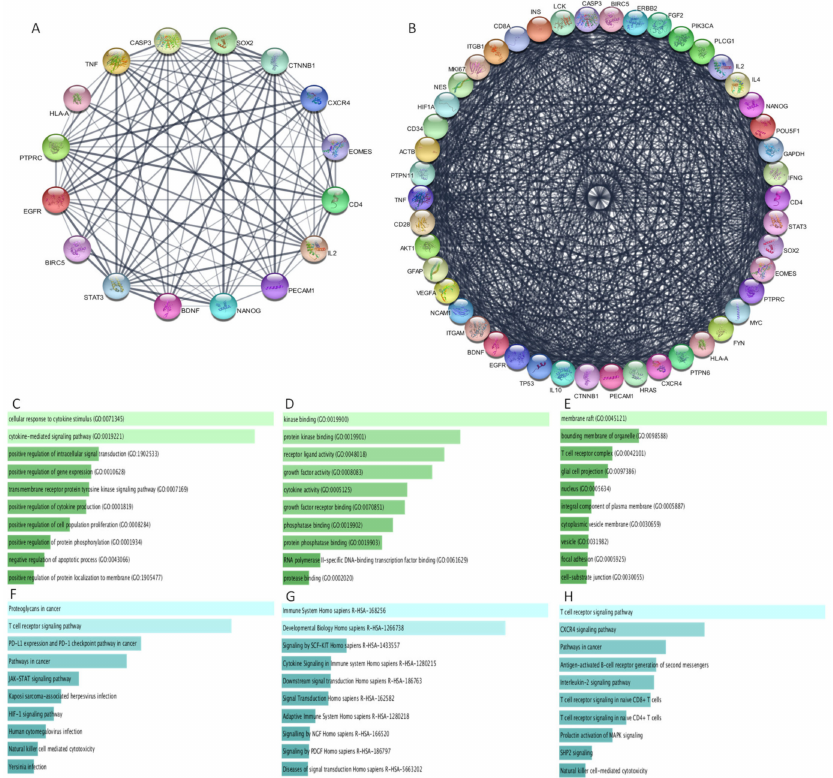
Figure 7. Protein–protein interaction and functional enrichment analysis of BIRC5, CXCR4, EOMES, BDNF, HLA-A, and PECAM1. ( A ) String analysis of CXCR4, BIRC5, BDNF, PECAM1, EOMES, and HLA-A with 10 and ( B ) with 40 identifiers performed in Cytoscape. ( C – H ) Bar Graph from Enrichr based on p -value ranking ( C ) GO Biological Processes ( D ) GO Molecular function ( E ) GO cellular component ( F ) KEGG human 2021 ( G ) Reactome 2016, and ( H ) Bioplanet